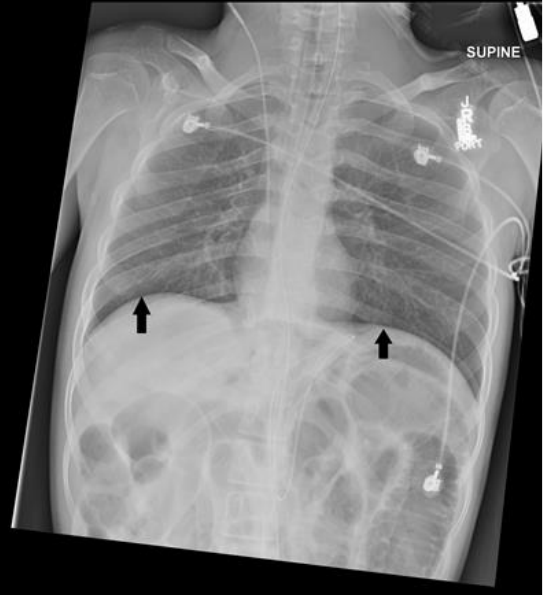
Figure 3 . Chest x-ray performed after needle decompression of abdomen demonstrating improved diaphragmatic excursion (black